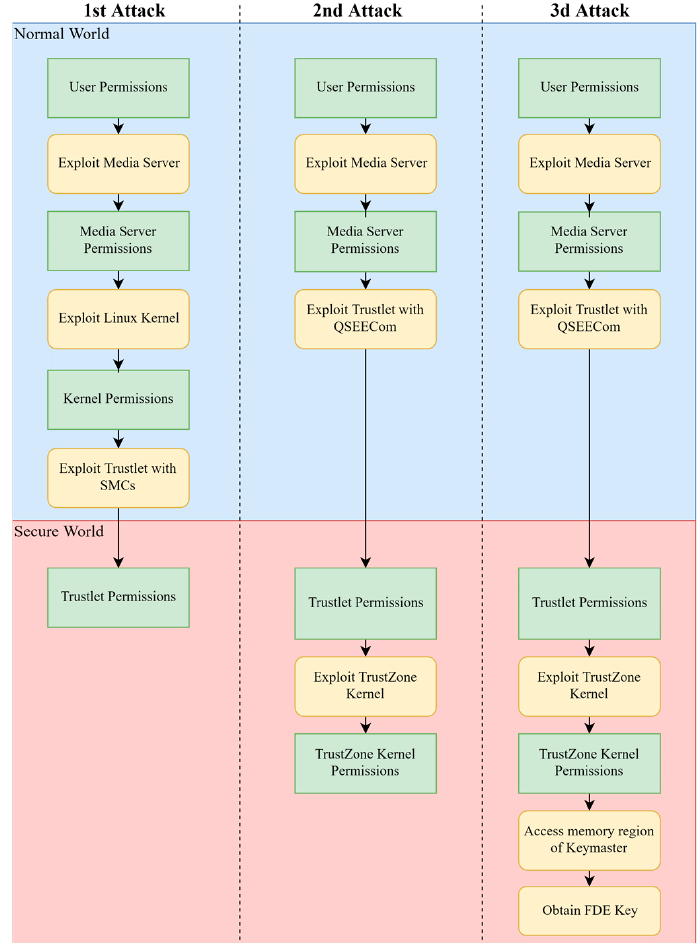
Figure 9. Three steps to complete TrustZone exploitation of the bits please